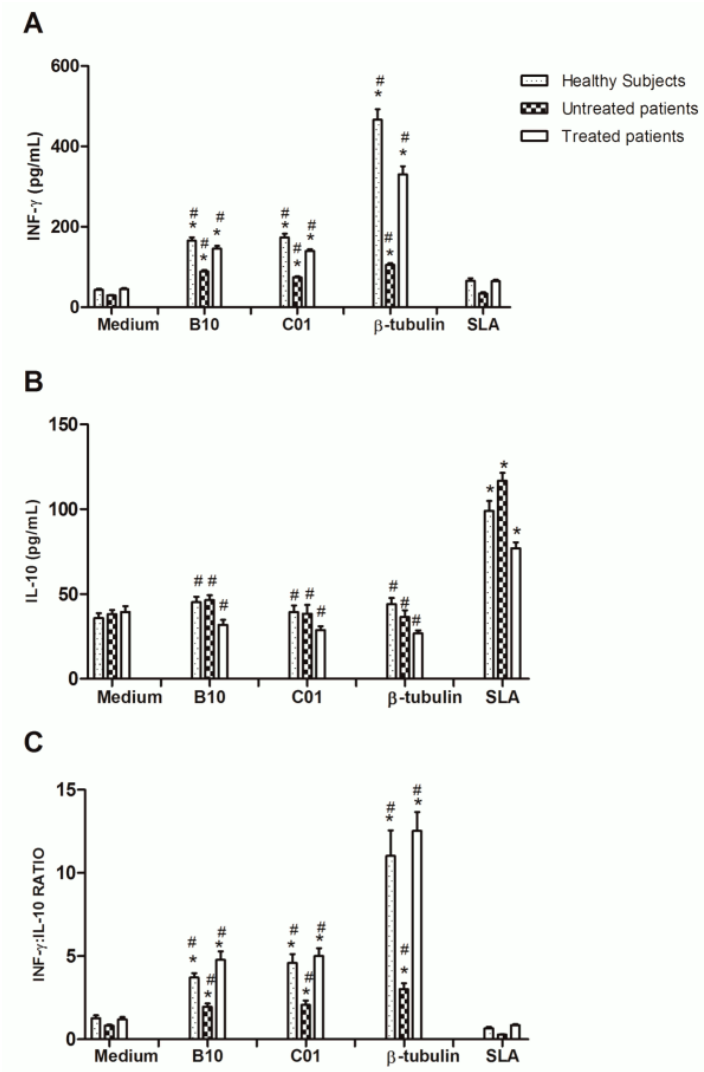
Figure 7. IFN- γ and IL-10 production in stimulated PBMC cultures derived from treated and untreated VL patients and control subjects. Peripheral blood mononuclear cells (PBMCs) were purified from blood samples from VL patients ( n = 10), which were collected before and six months after treatment, as well as from healthy subjects living in an endemic area of disease ( n = 10). Cells (10 7 ) were non-stimulated (medium) or stimulated with B10, C01 or irrelevant (NRP) phage clones (10 10 molecules, each), with the B10 or C01 peptides (10 µg/mL each) or with β -tubulin or L. infantum SLA (10 and 25 µg/mL, respectively), for 5 days at 37 °C in 5% CO 2 . Cell supernatant was collected and the specific IFN- γ and IL-10 production was measured by capture ELISA (in A and B , respectively). The ratio between the IFN- γ and IL-10 levels was calculated and is also shown (in C ). Bars indicate the mean ± standard deviation of the groups. * indicates statistically significant difference in relation to the medium ( p < 0.0001). # indicates statistically significant difference in relation to the SLA L. infantum stimulus ( p < 0.0001).